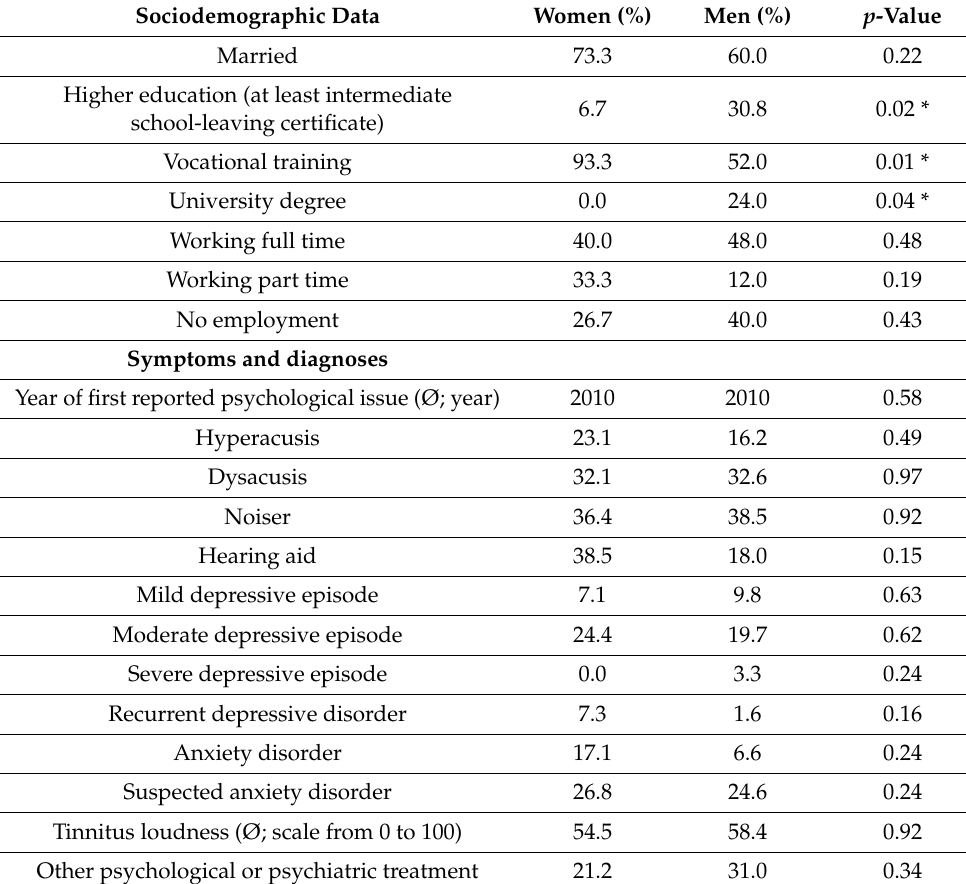
Table 1. Overview of gender differences regarding sociodemographic data, psychiatric diagnoses, and tinnitus-related symptoms in the entire sample. * significant differences with p < 0.05.